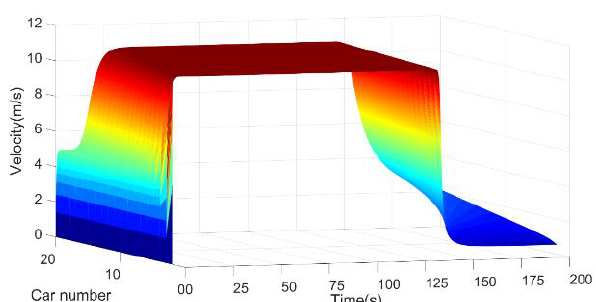
Figure 4. Vehicle velocities in driving situation 2.